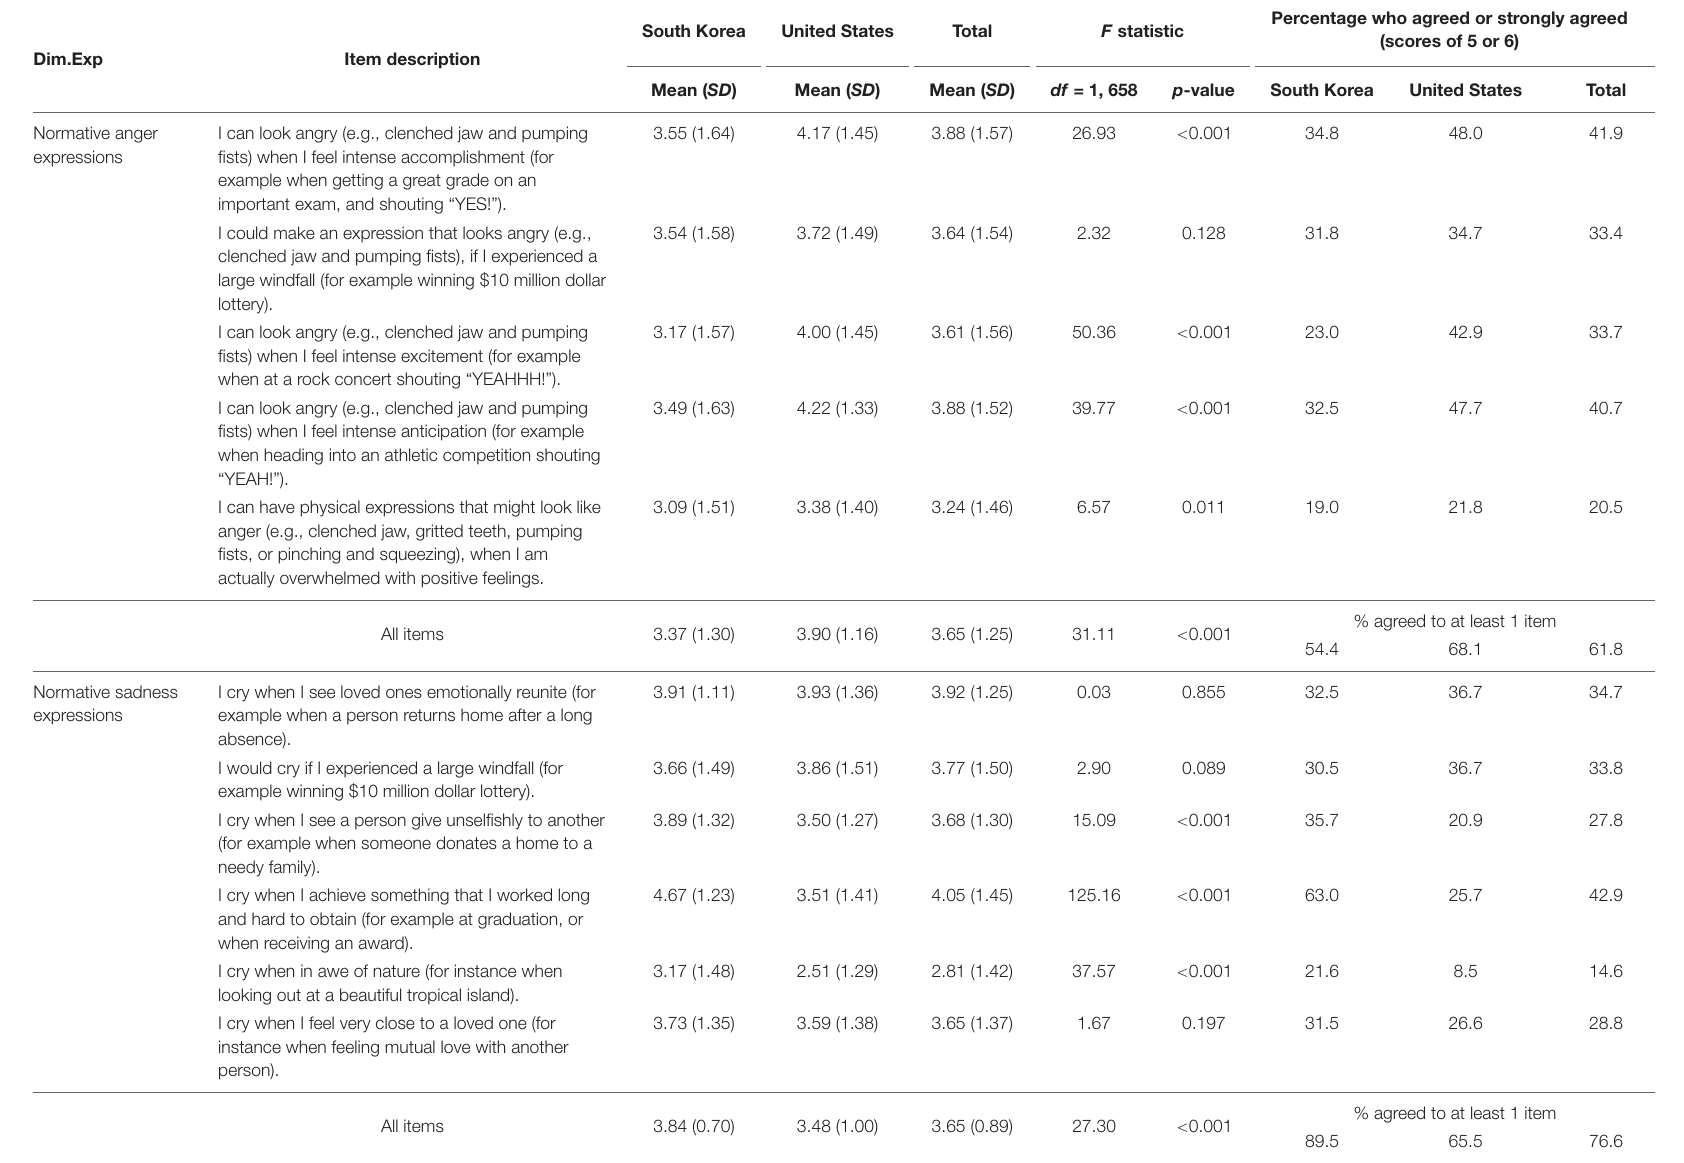
South Korea United States Total F statistic